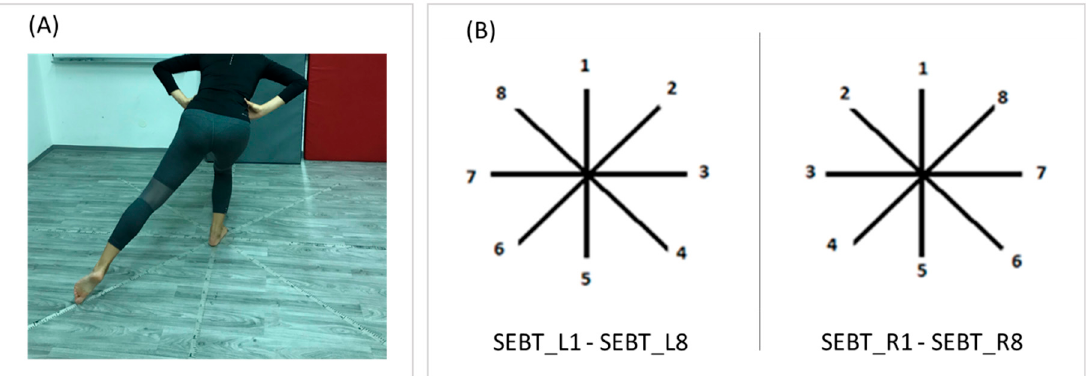
Figure 1. Star Excursion Balance Test (SEBT) execution ( A ), and SEBT scoring ( B ) while standing on the left leg (SEBT_L1–SEBT_L8), and while standing on the right leg (SEBT_R1– SEBT_R8)